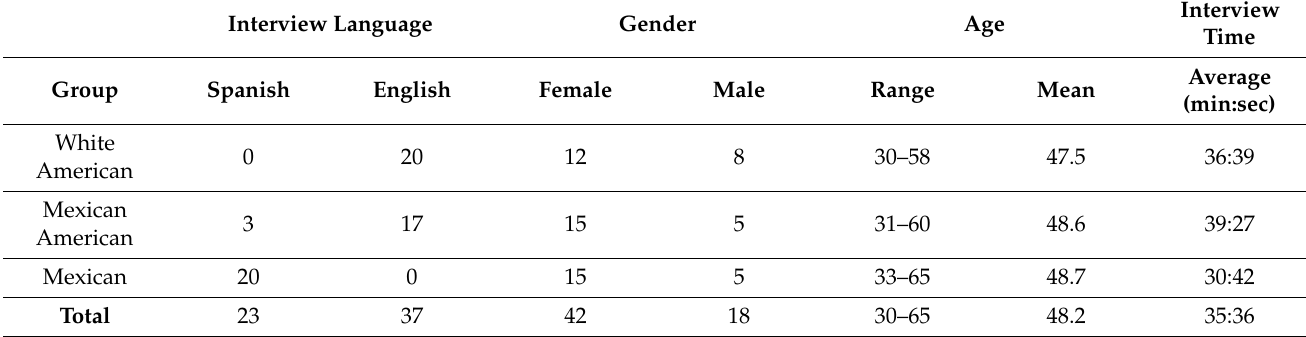
Table 2. Participant